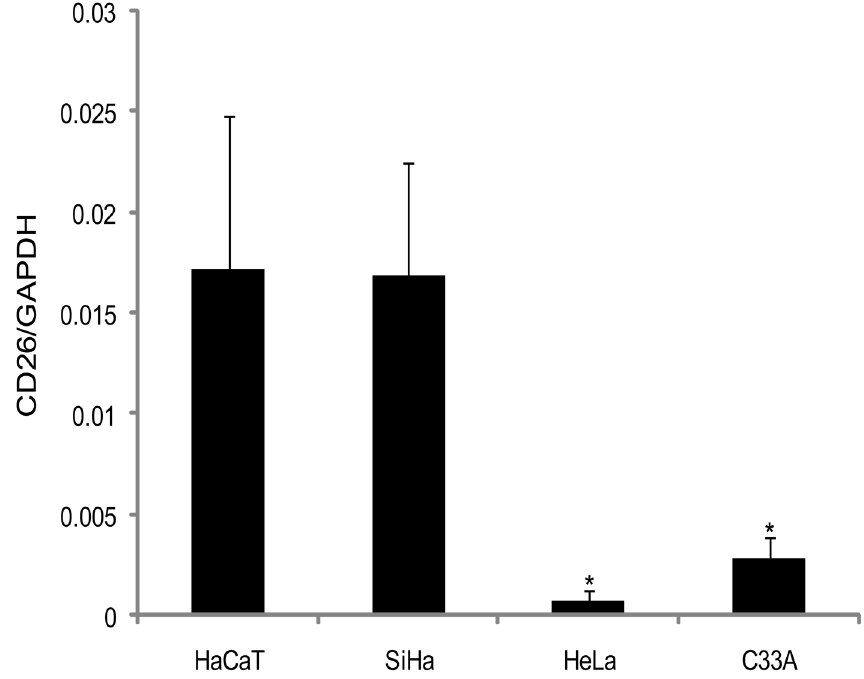
Fig 2. DPPIV/CD26 expression profile determined by real-time RT-PCR analysis. Quantitative real-time RT-PCR analysis of DPPIV/CD26 expression in cervical cancer cells (SiHa, HeLa and C33A) and immortalized keratinocytes (HaCaT). The total RNA was isolated and the cDNA was analyzed with the primers as described in Materials and methods section. Bars represent mean ± SD for three experiments. * Indicates statistical significance when cervical cancer cell lines were compared to the non-tumorigenic cell line, HaCaT (ANOVA followed by Tukey ’ s test, p (cid:1) 0.05).